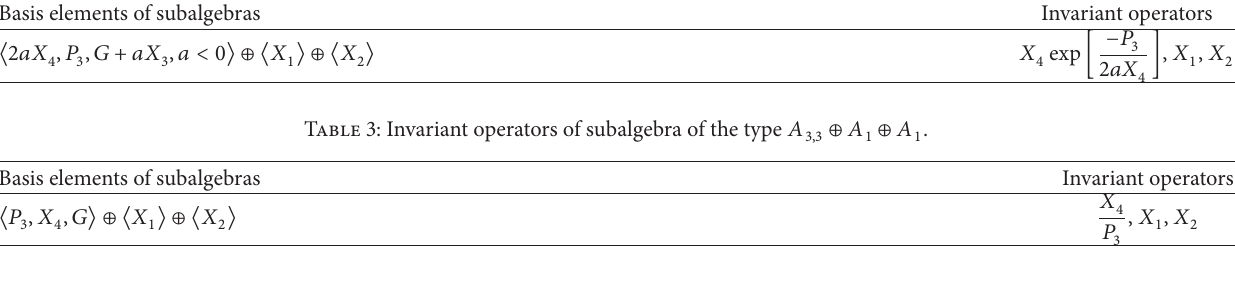
Table 4: Invariant operators of subalgebras of the type 𝐴 3,4 ⊕ 𝐴 1 ⊕ 𝐴 1 . Basis elements of